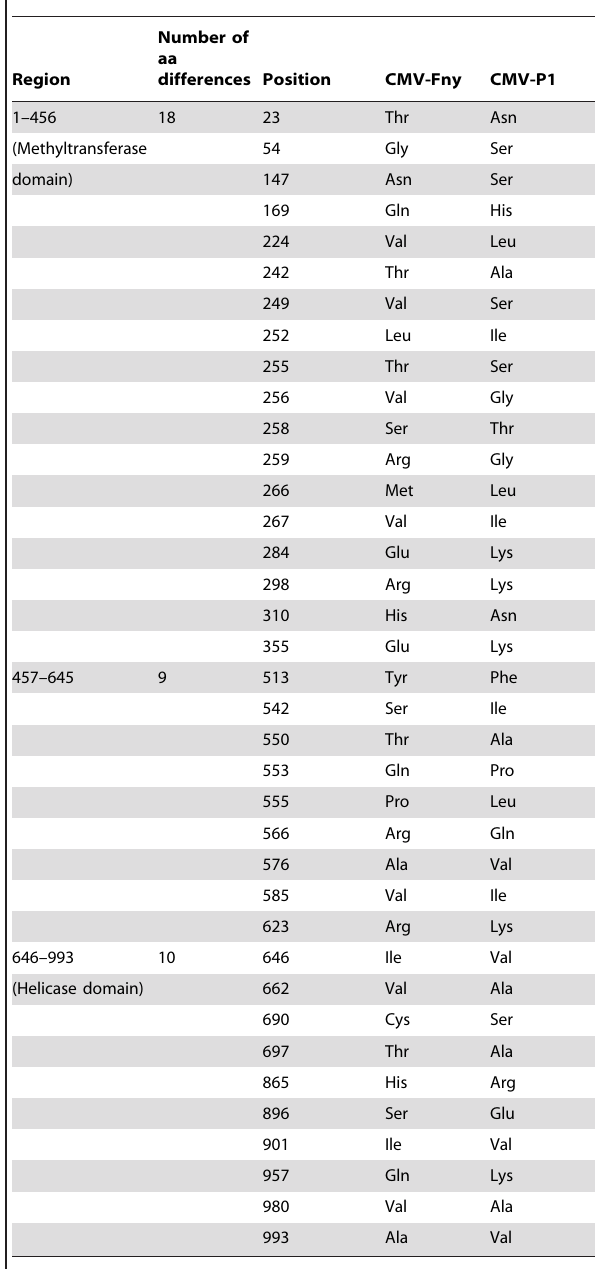
Table 1. Amino acid differences in protein 1a of CMV-Fny and